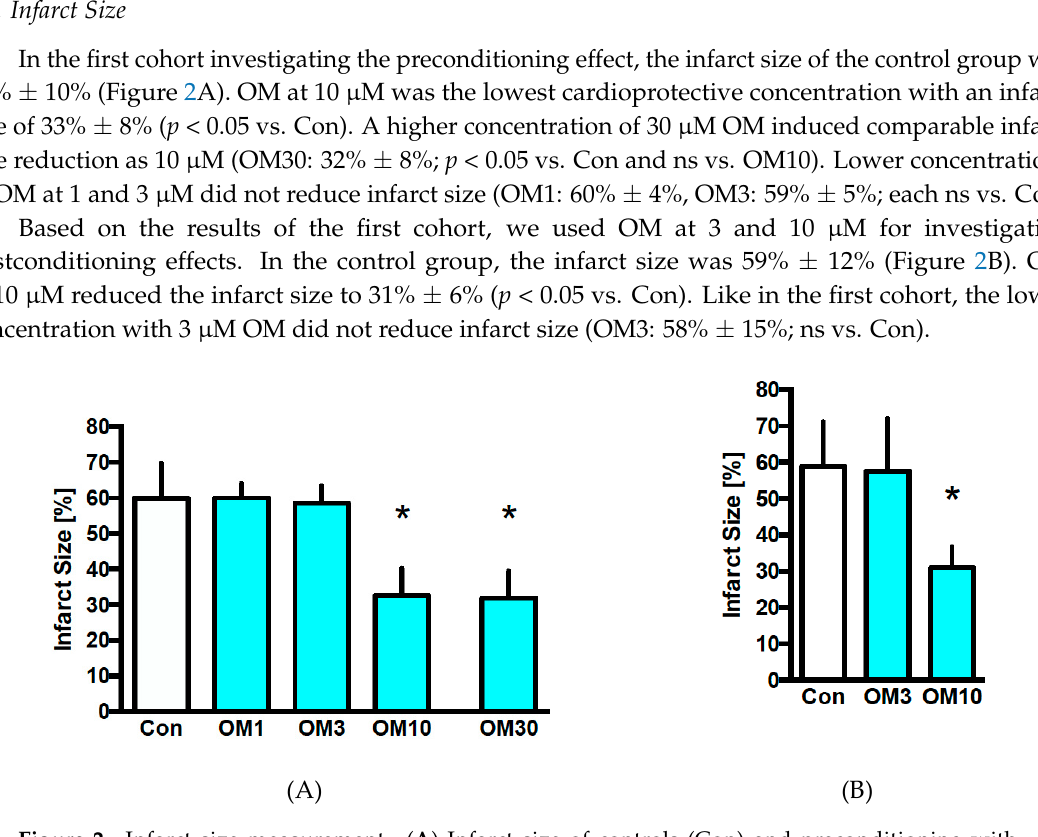
Figure 2. Infarct size measurement. ( A ) Infarct size of controls (Con) and preconditioning with omecamtiv mecarbil (OM). ( B ) Infarct size of controls (Con) and postconditioning with omecamtiv mecarbil (OM) * p < 0.05 vs. Con.